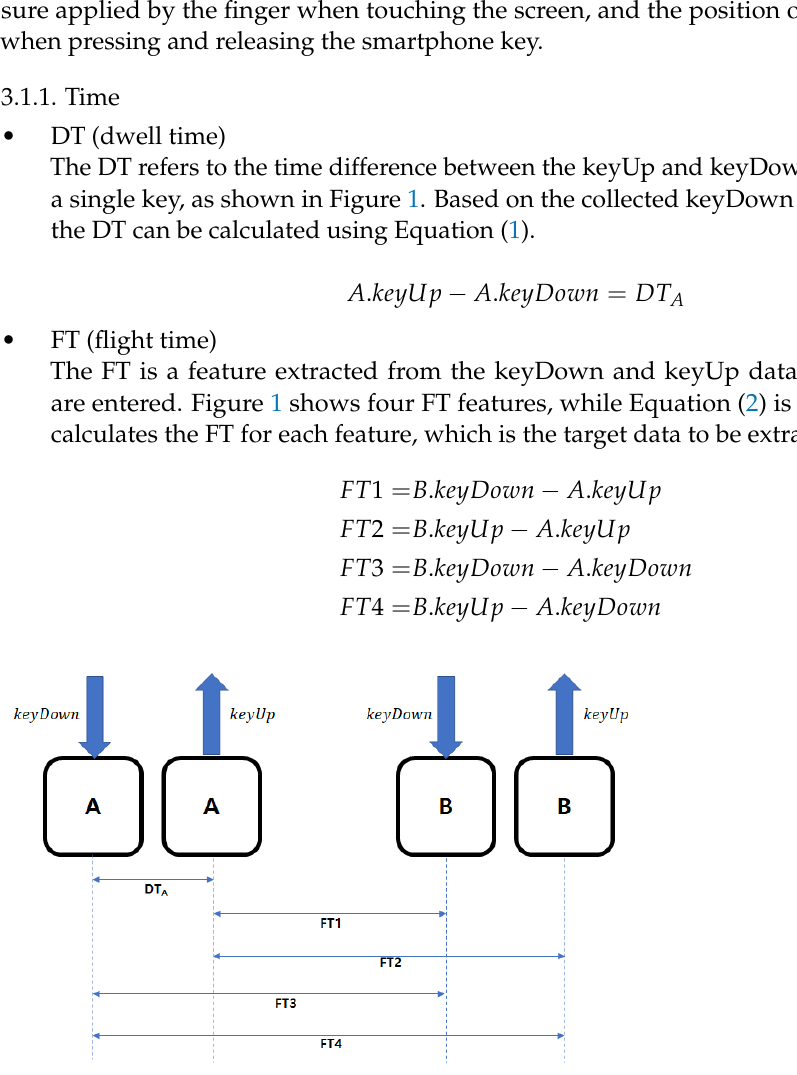
Figure 1. Time feature